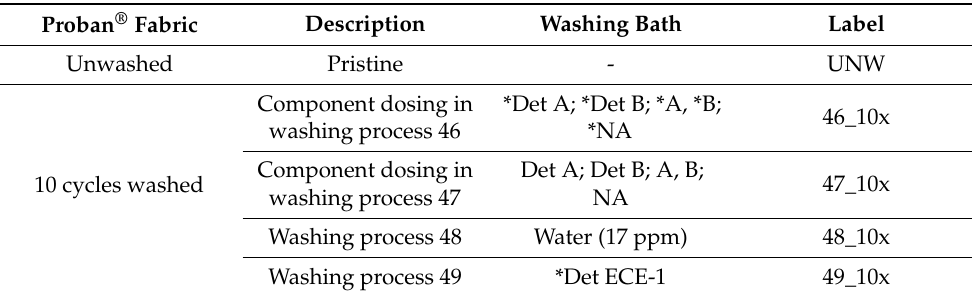
Table 2. Description and sample labels.